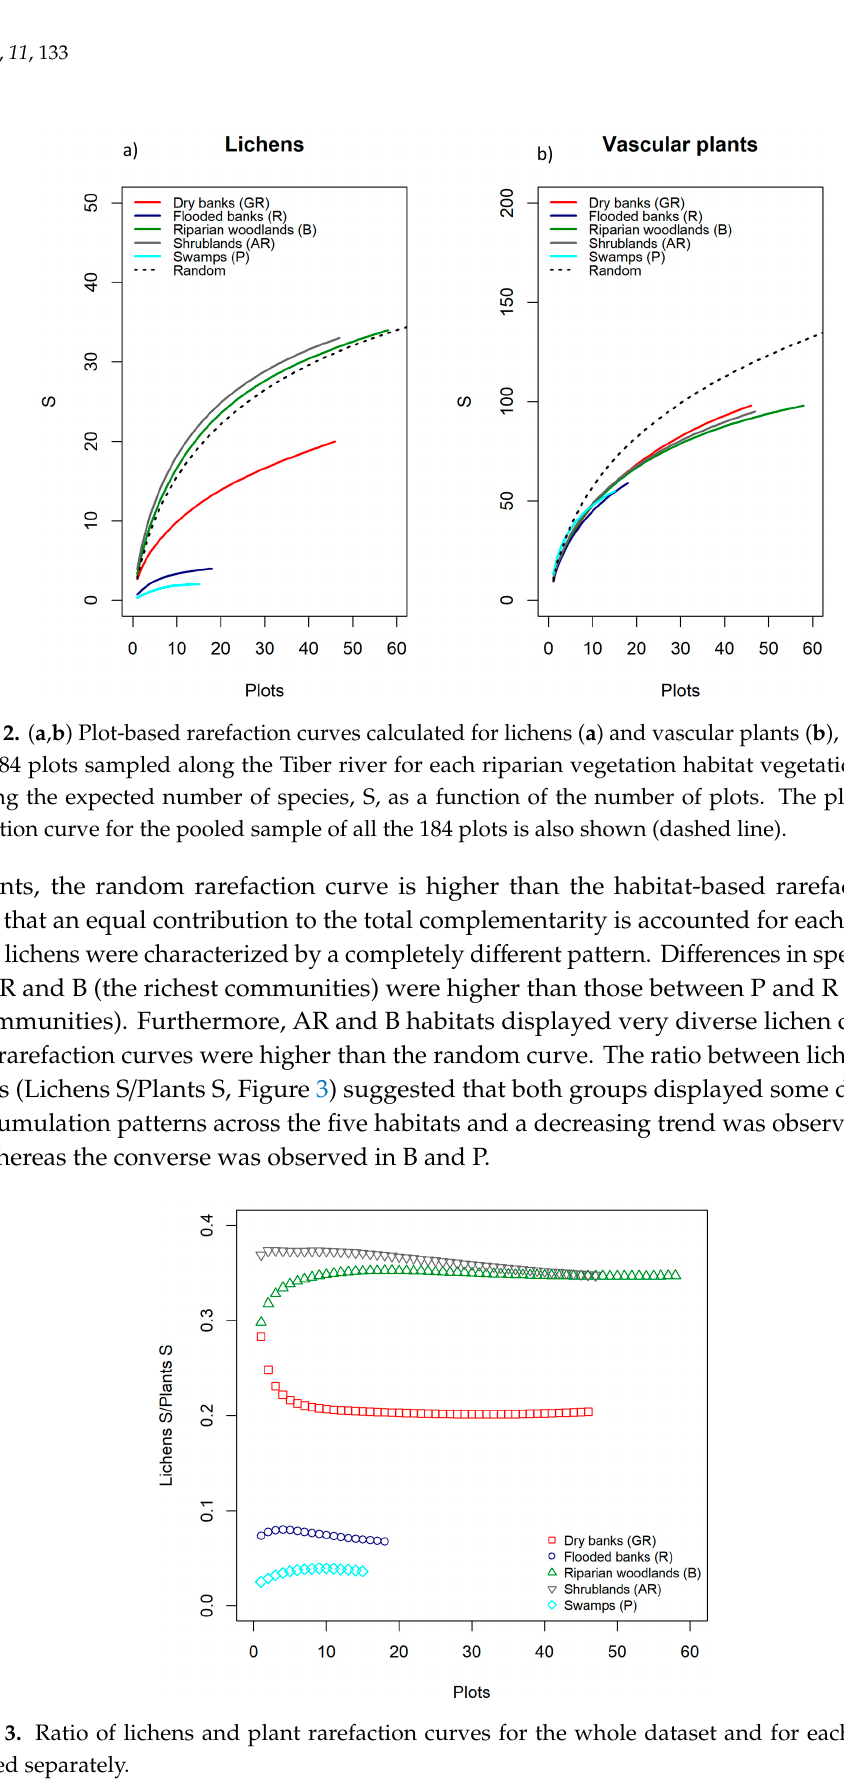
Table 3. Correlation (Spearman’s ρ ) between the Bray–Curtis (log-transformed abundance data) and Jaccard dissimilarity matrices (occurrence data) of plants and lichens. p -values were calculated by using Monte Carlo randomization tests (999 permutations). Significant correlation coefficients are in bold. AR—Shrublands, B—Riparian woods, GR—Dry Banks, P—Swamps, R—Flooded Banks. Dataset